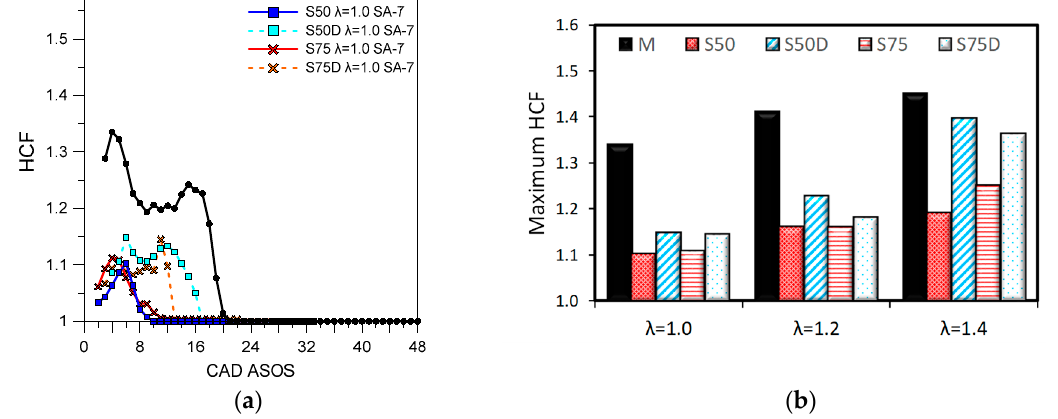
Figure 19. ( a ) Average Heywood Circularity Factor trend at stoichiometric air-fuel ratio ( λ = 1.0) and ( b ) Maximum Heywood Circularity Factor for all air-fuel ratios.